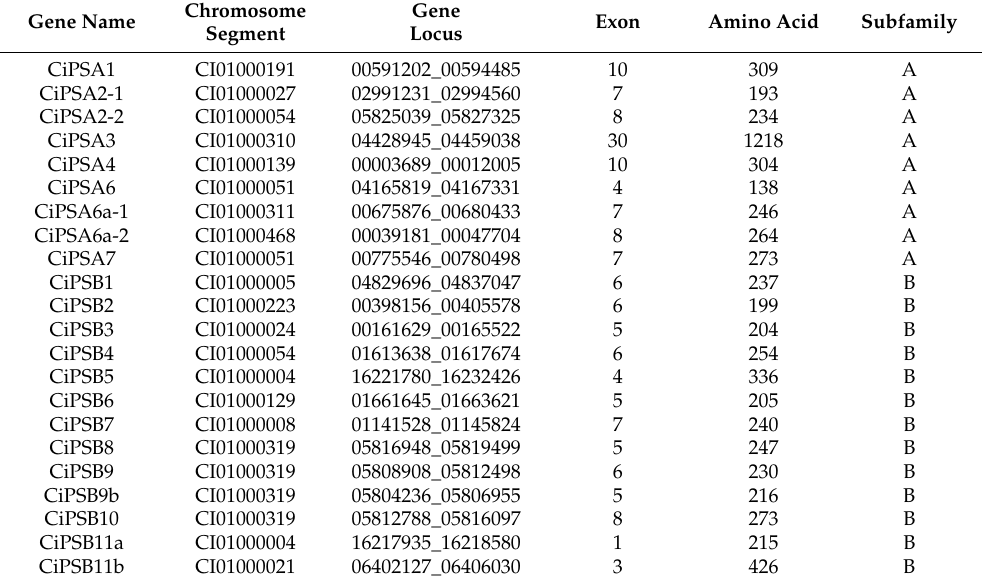
Table 1. List of all CiPS genes identified in the grass carp